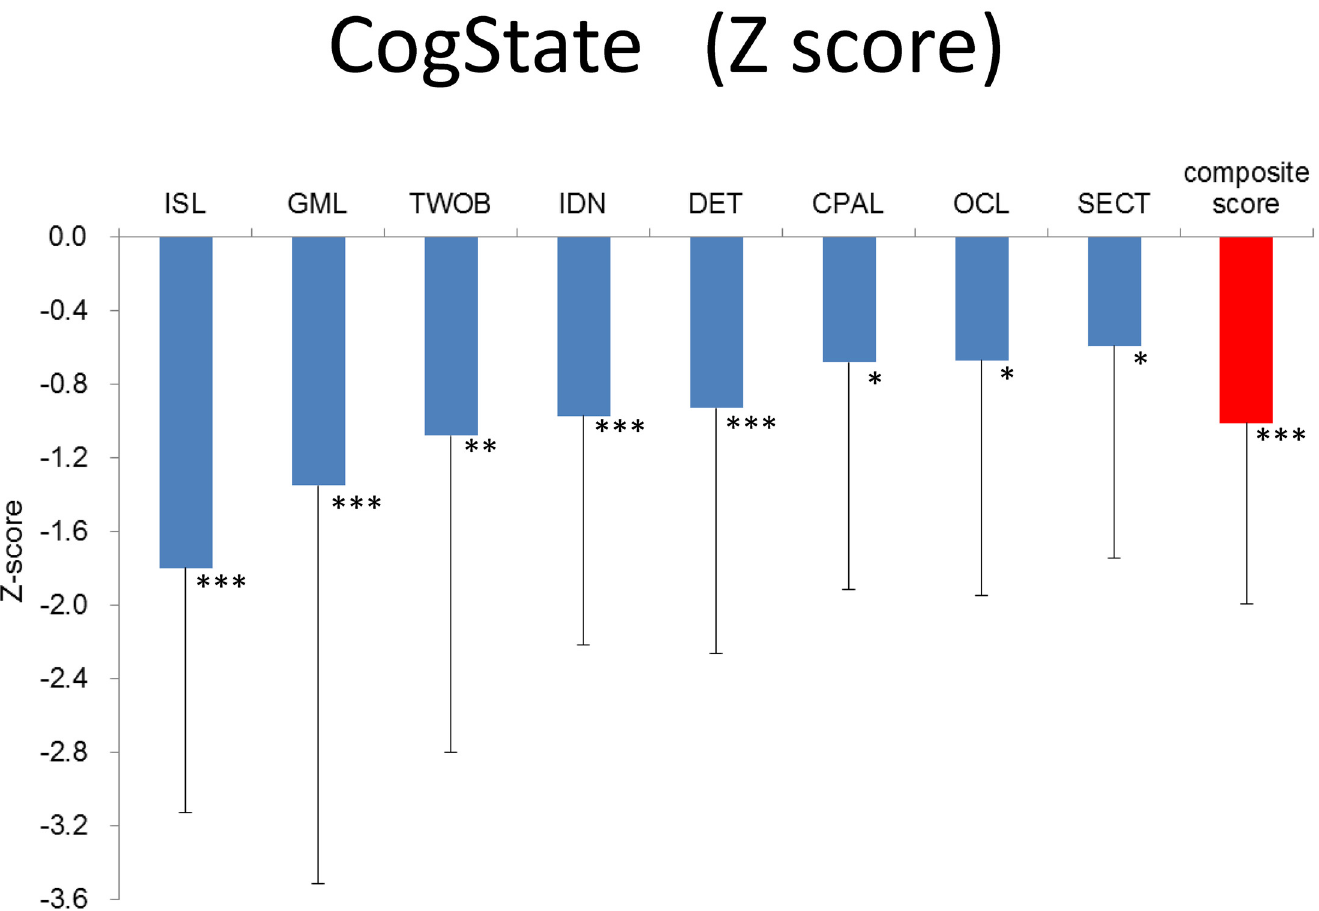
Fig 1. Magnitude of impairment in forensic patients relative to healthy controls on each CSB measure. Mean ± SD of Z-scores are given. Z-score was created by setting controls ’ mean to zero and SD to one. Abbreviation: ISL International Shopping List Task, GML Groton Maze Learning Task, TWOB Two Back Task, IDN Identification Task, DET Detection Task, CPAL Continuous Paired Association Task, OCL One Card Learning Task, SECT Social Emotional Cognitive Task. * p < 0.05, ** p < 0.01, *** p <